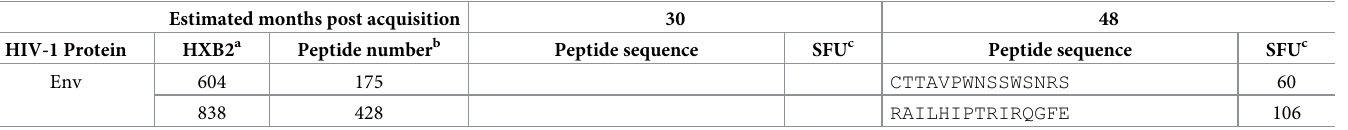
a Location of peptides’ first amino acid relative to HIV-1 HXB2, b PTE peptide number as supplied, c Spot forming units (SFU) per million expanded CD8